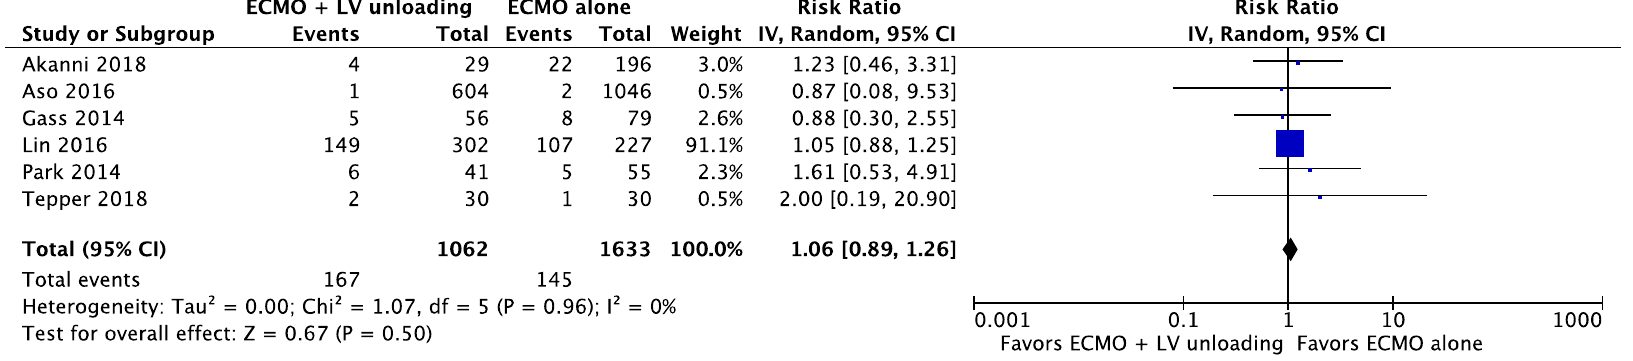
Figure A8. Limb complications.